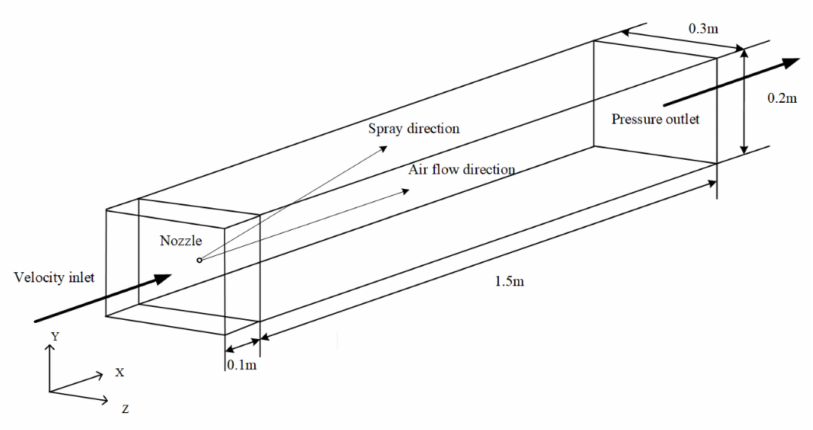
Figure 4. Physical